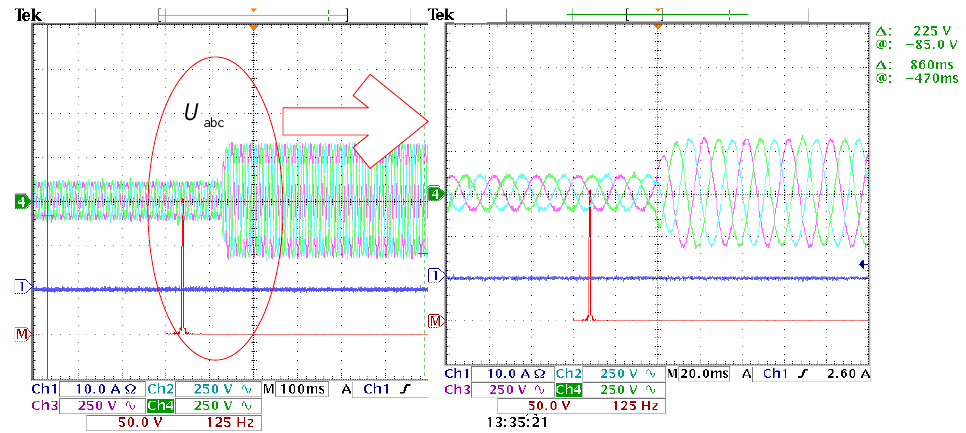
Figure 20. Experimental results of the proposed control strategy with LCO under unbalanced